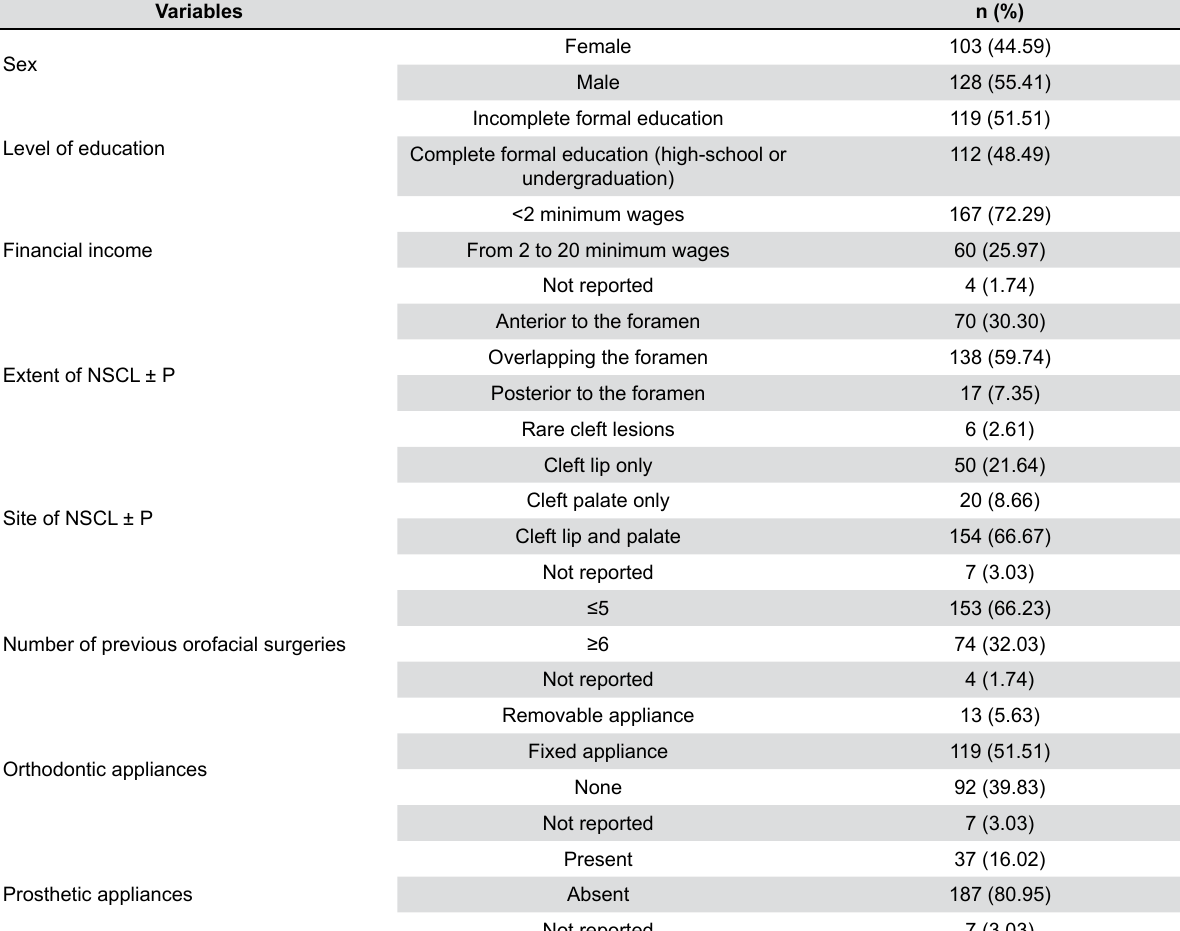
Table 1- Sample distribution according to the studied